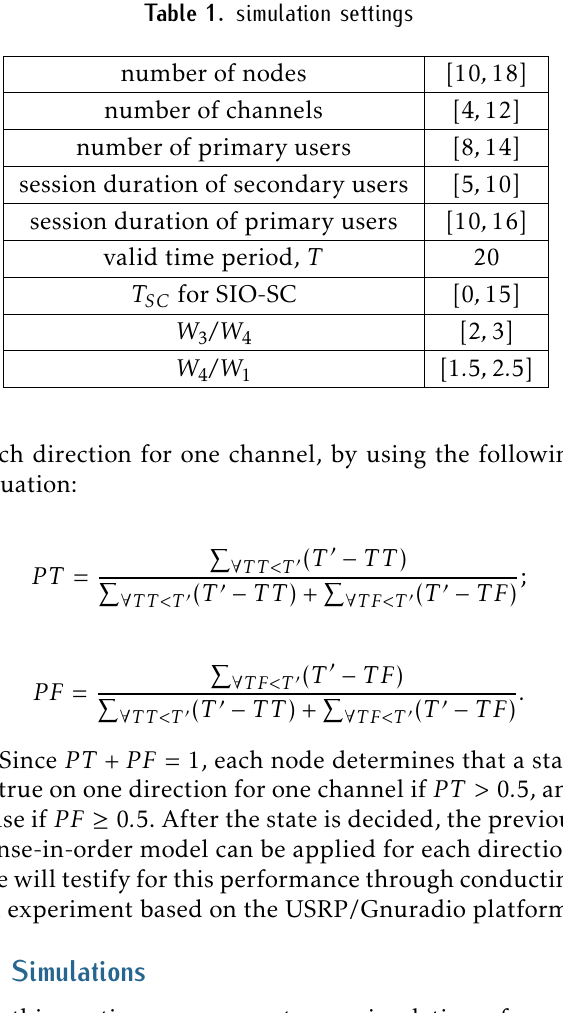
Improvement For Distributed Spectrum Sensing in Cognitive Radio